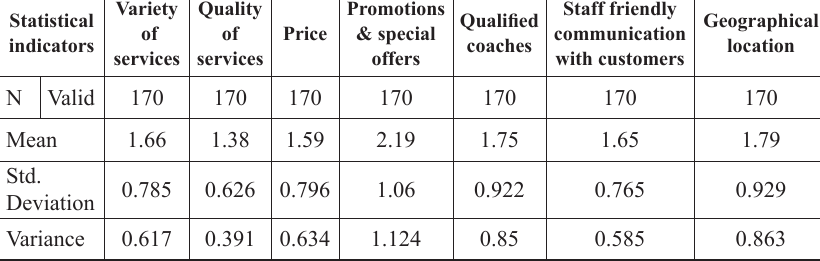
Table 2. The motivator strength for consumers selecting a wellness- fitness centre in